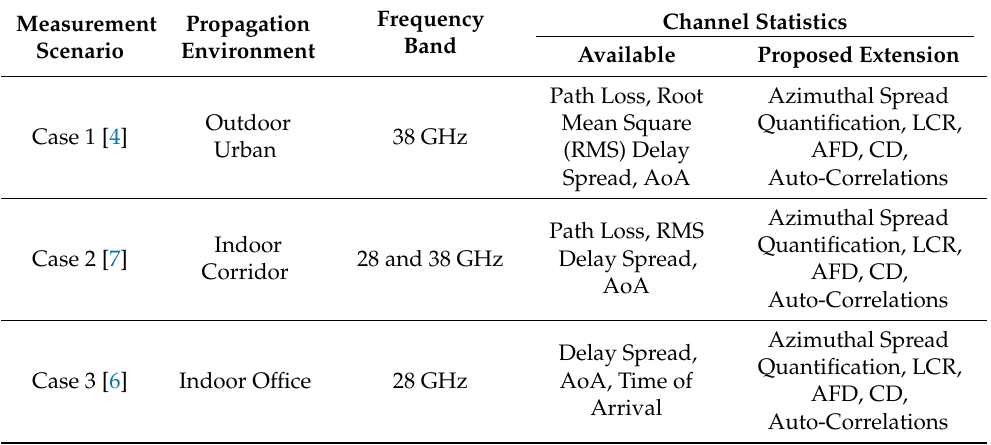
Table 1. Characteristics of considered measurement scenarios and the proposed